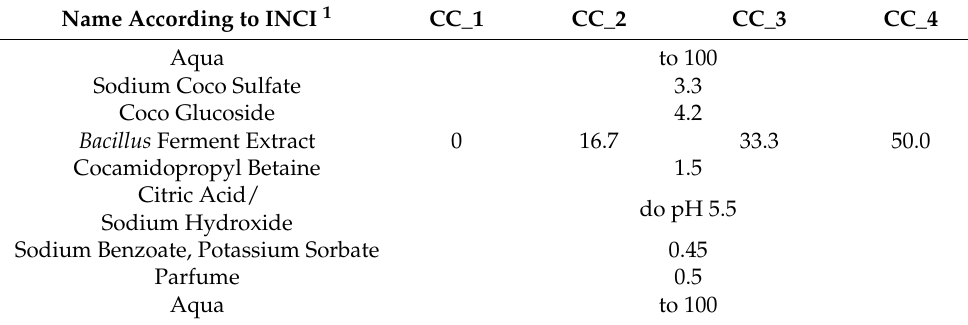
Table 2. Model shower gel formulations containing digestate